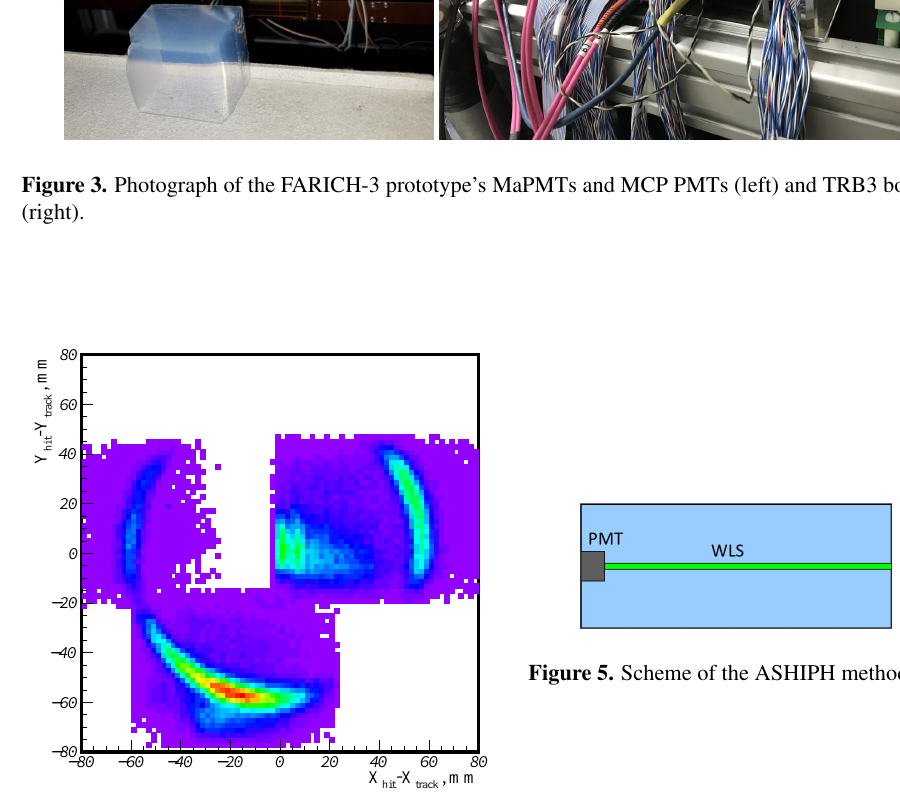
Figure 4. An example of the hit map for 4-layer aerogel (430f61) in the FARICH-3 prototype.